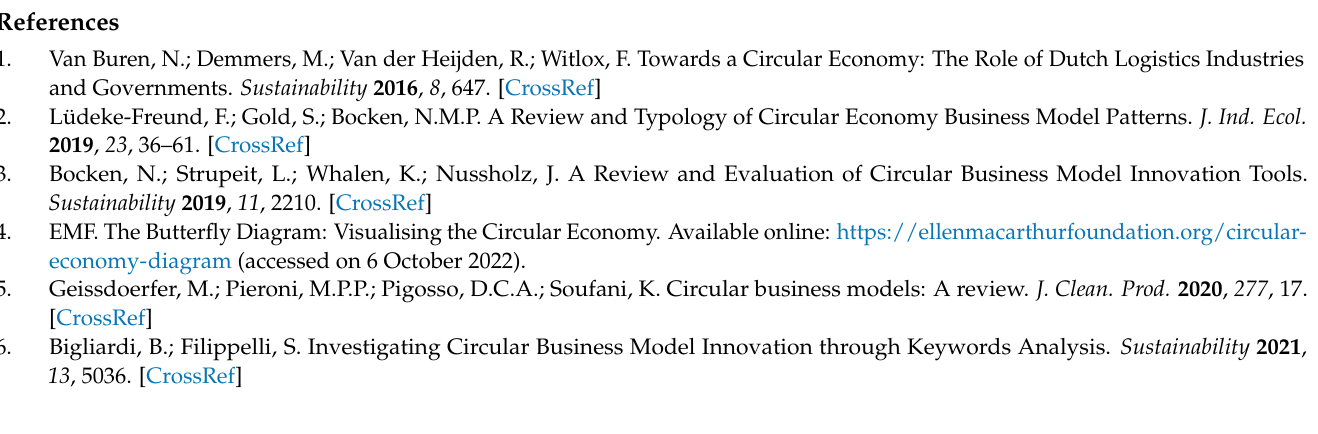
Table S2.6. Elements of data and digitalization. Table S2.7. Elements of circular supply chain. Table S2.8. Elements of stakeholders’ orientation and perspectives. Table S2.9. Elements of policy and regulations. Table S2.10. Elements of recycling focused CBM research